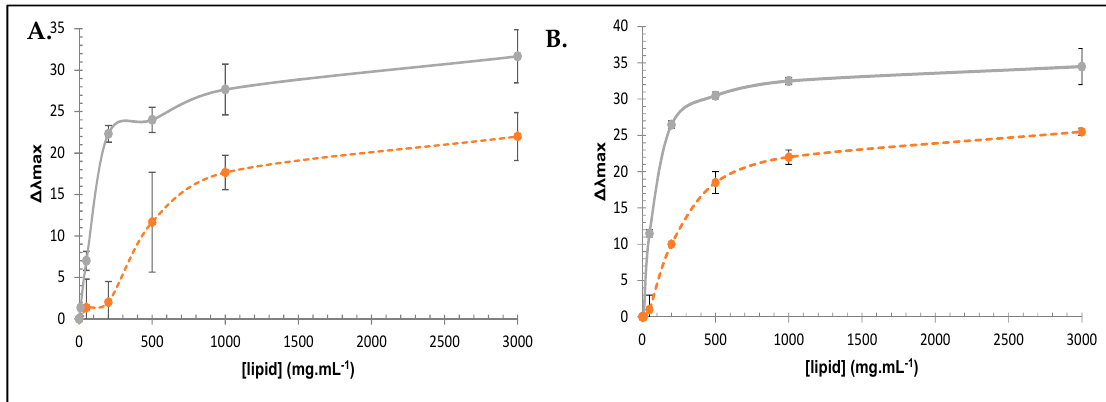
Figure 8. Lipid-induced changes in tryptophan fluorescence of peptide 11 (full line) and 10 (dashed line). Blue-shift for tryptophan in the wavelength of maximal emission in the presence of large unilamellar vesicles (LUVs) produced from S. aureus ATCC25923’ phospholipids ( A ) and from E.coli K12 ( B ) (see Supporting Information).